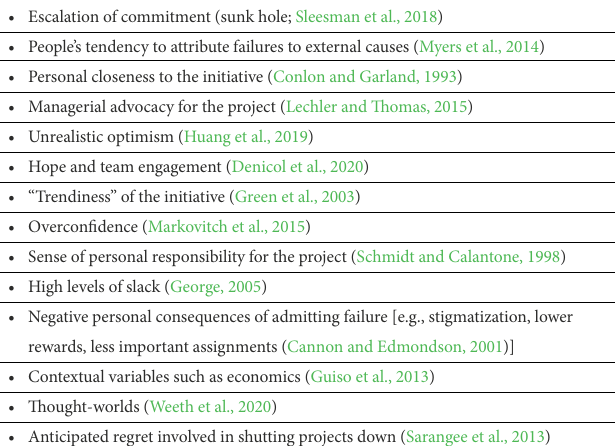
TABLE 1 Explanations for continuing investments in bad project